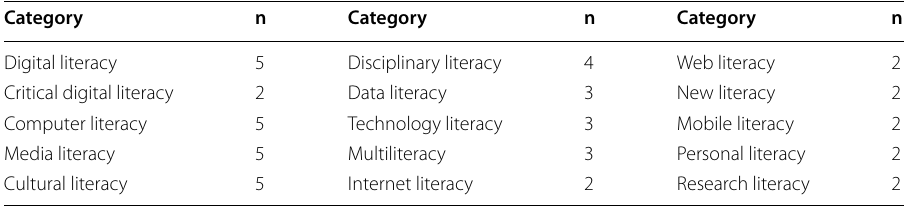
Table 3 Other mentioned categories (n Advanced digital assessment